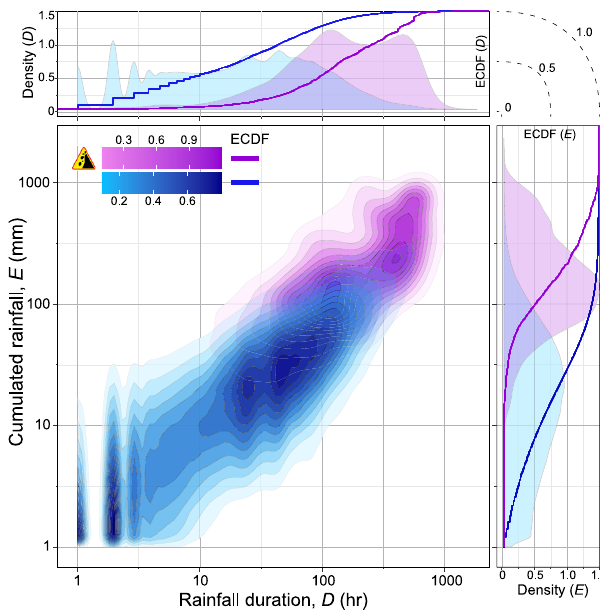
Fig.2|Empiricalfrequencydensitydistributionsofrainfallduration, D (h)and hourly cumulated rainfall, E (mm) for 780,766 rainfall events in Italy obtained through Two-Dimensional Kernel Density Estimation, KDE2d 79 . Violet shows density for 2472 rainfall events from February 2002 to December 2020 for which the occurrence of at least one landslide is known. Blue shows density for 778,294 rainfall events for which the occurrenceoflandslide isnot known. Upperand right plots show marginal distributions of D and E (violet and blue areas), and related empirical cumulative distribution functions, ECDF (violet and blue lines) normal- ised to the number of rainfall events with and without landslides,